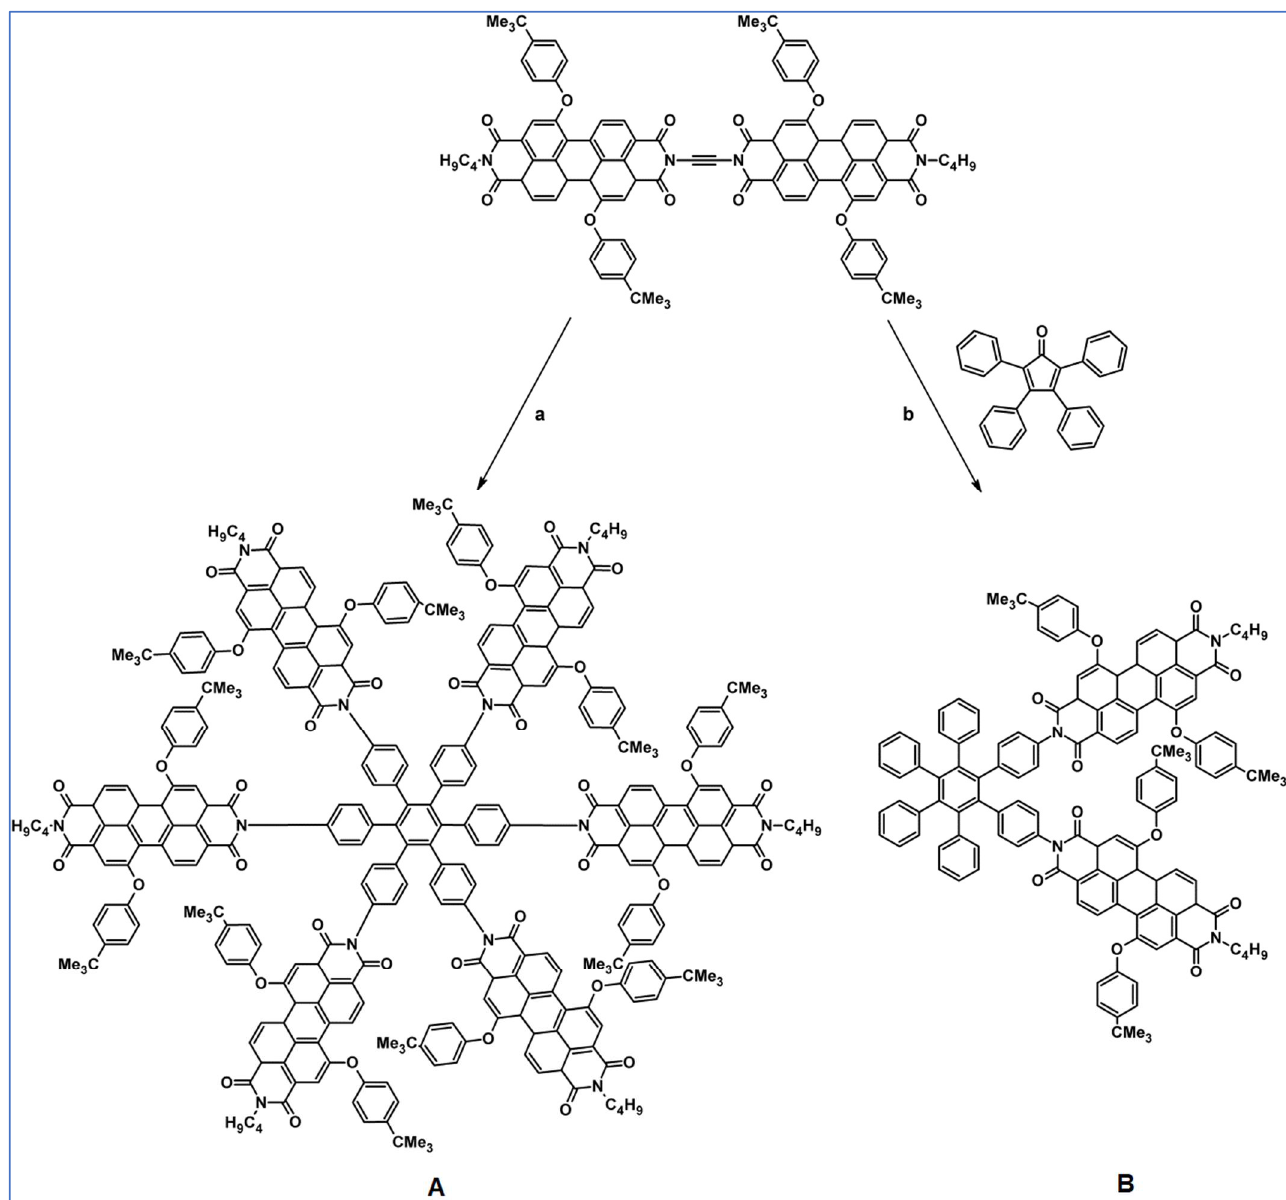
Scheme 105. Syntheses of HPB derivatives bearing two or six PBI-moieties via DA cycloaddition or Co-catalyzed cyclotrimerization, respectively [160]. Reagents and conditions: a = dioxane, [Co 2 (CO) 8 ],